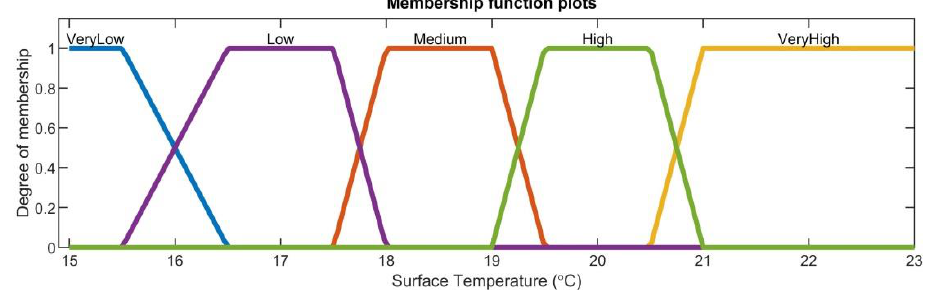
Figure 3. Trapezoidal membership functions for the fuzzy sets of Surface Temperature imported in the FIS.